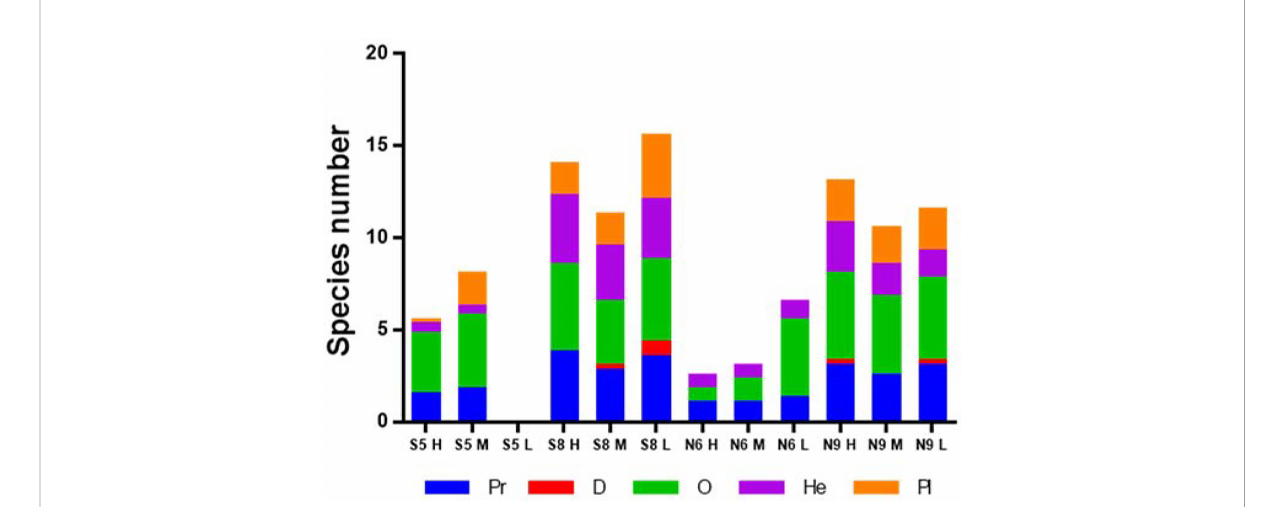
FIGURE 4 Average functional group species richness. Pr, predator; D, detritivore; O, omnivore; He, herbivore; and Pl, planktivore.